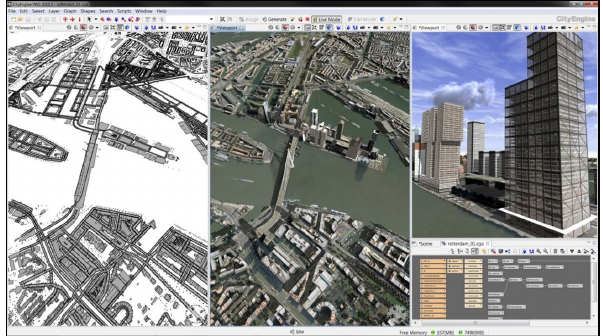
Figure 4. Generation of 3D city model in CityEngine (Source: http://dragons8mycat.com)